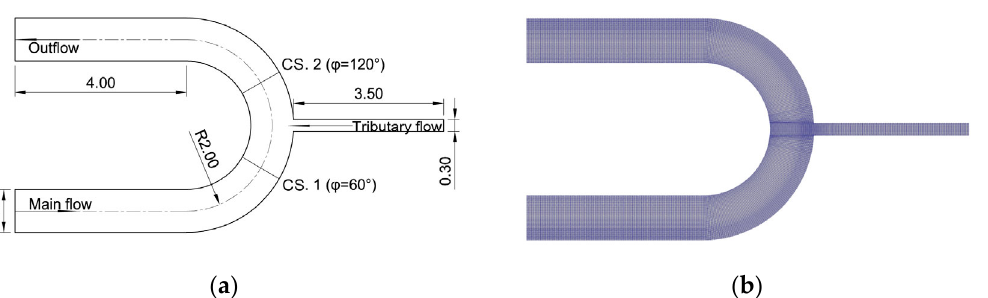
Figure 5. ( a ) The schematic of a U ‐ shape open channel with a tributary (units: m); ( b ) The local refined calculating mesh.